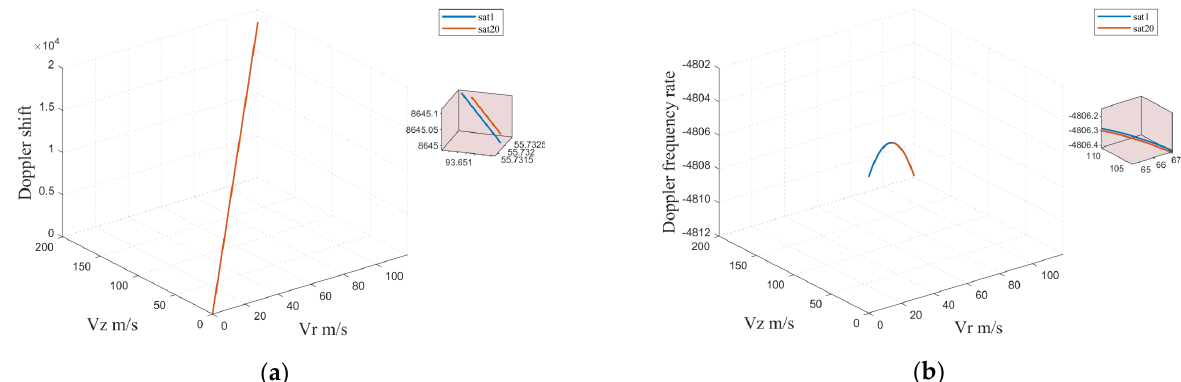
Figure 5. ( a ) Doppler centroid with the velocity of the 1st and 20th image; ( b ) Doppler frequency rate with the velocity of the 1st and 20th image.